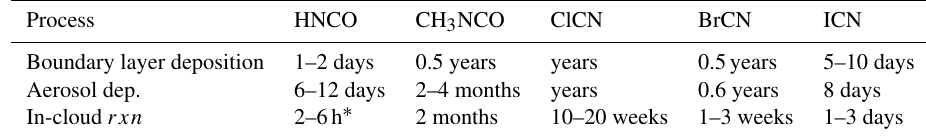
Table 3. Estimates of HNCO, CH 3 NCO, and XCN compounds against loss due to heterogeneous processes. Process